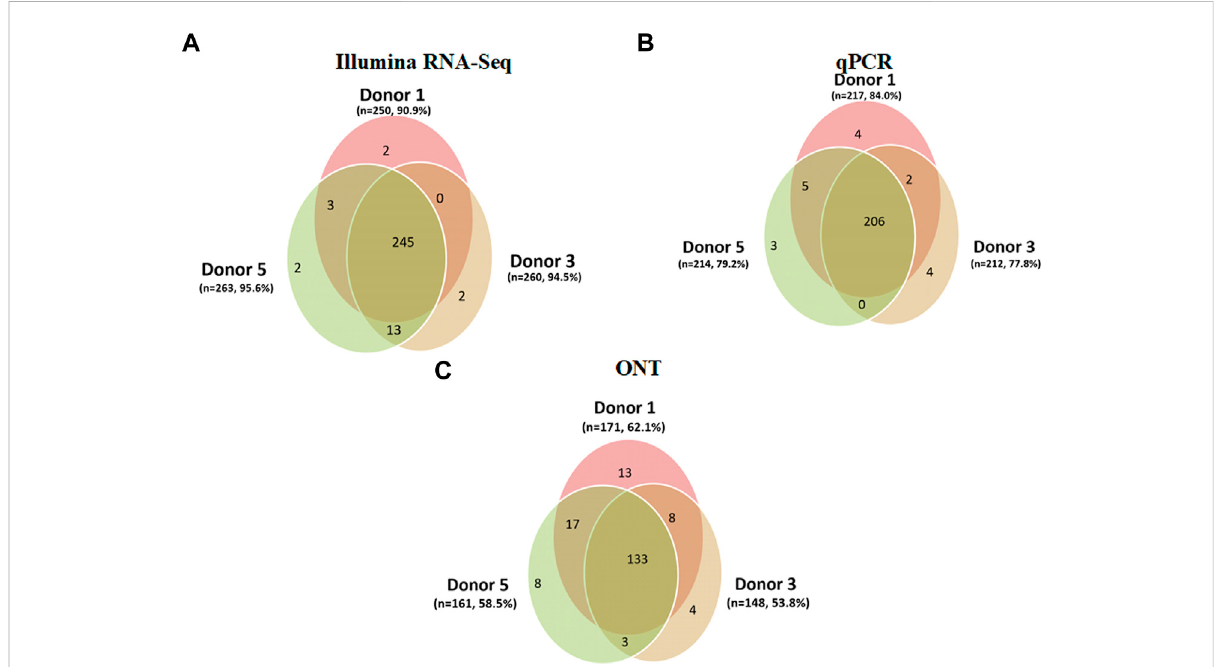
FIGURE 4 Resultsoftheanalysisofthethreehumanlivertissuesamples(donor1,donor3,anddonor5)indicatingthenumberoftheChr18transcripts( n = 275) detected using (A) Illumina RNA-Seq data (FPKM > 0); a total of 267 transcripts were detected, corresponding to 97.0% of the total number of protein-codinggenes. (B) qPCR(numberofcDNAcopiespercell, S t ≤ 40);atotalof224transcriptsweredetected(81.4%). (C) ONT(TPM > 0);atotal of 186 transcripts were detected